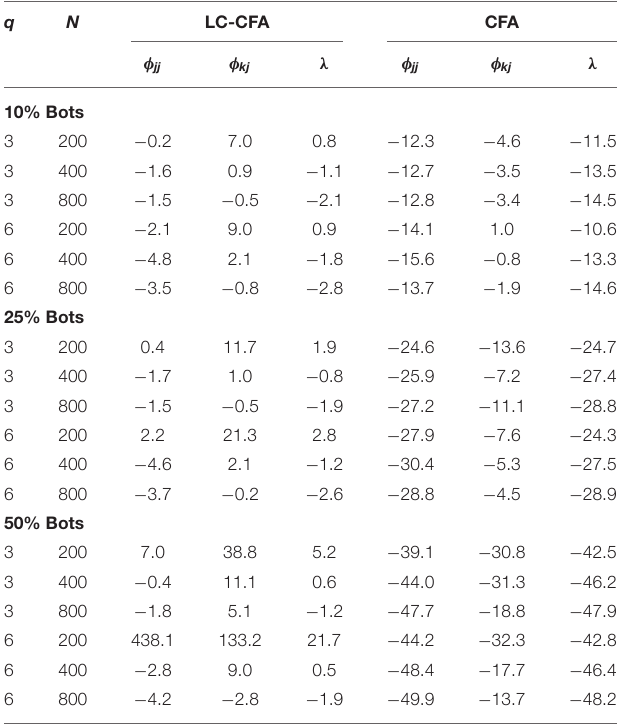
TABLE 3 | Average parameter bias for the LC-CFA and the CFA across conditions of sample size ( N ), number of factors ( q ), and proportion of